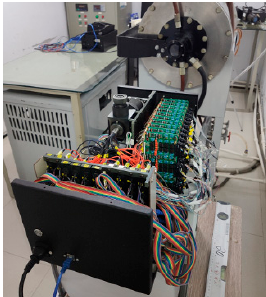
Figure 12. Field calibration.